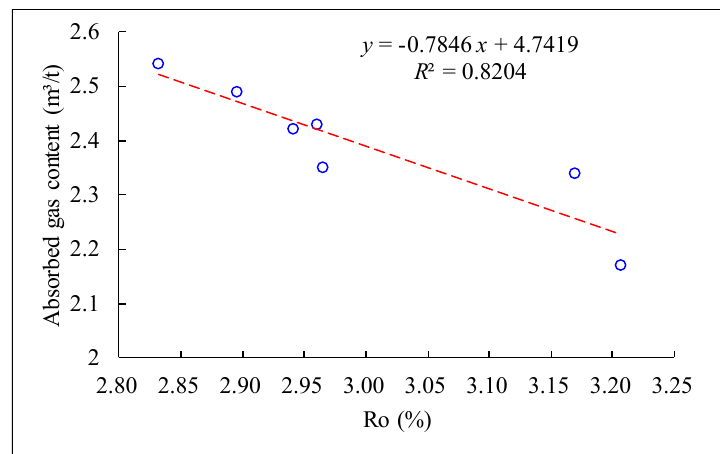
Figure 13. Negative relationship between vitrinite reflectance ( R o ) and adsorbed gas content of Xinkailing shale.